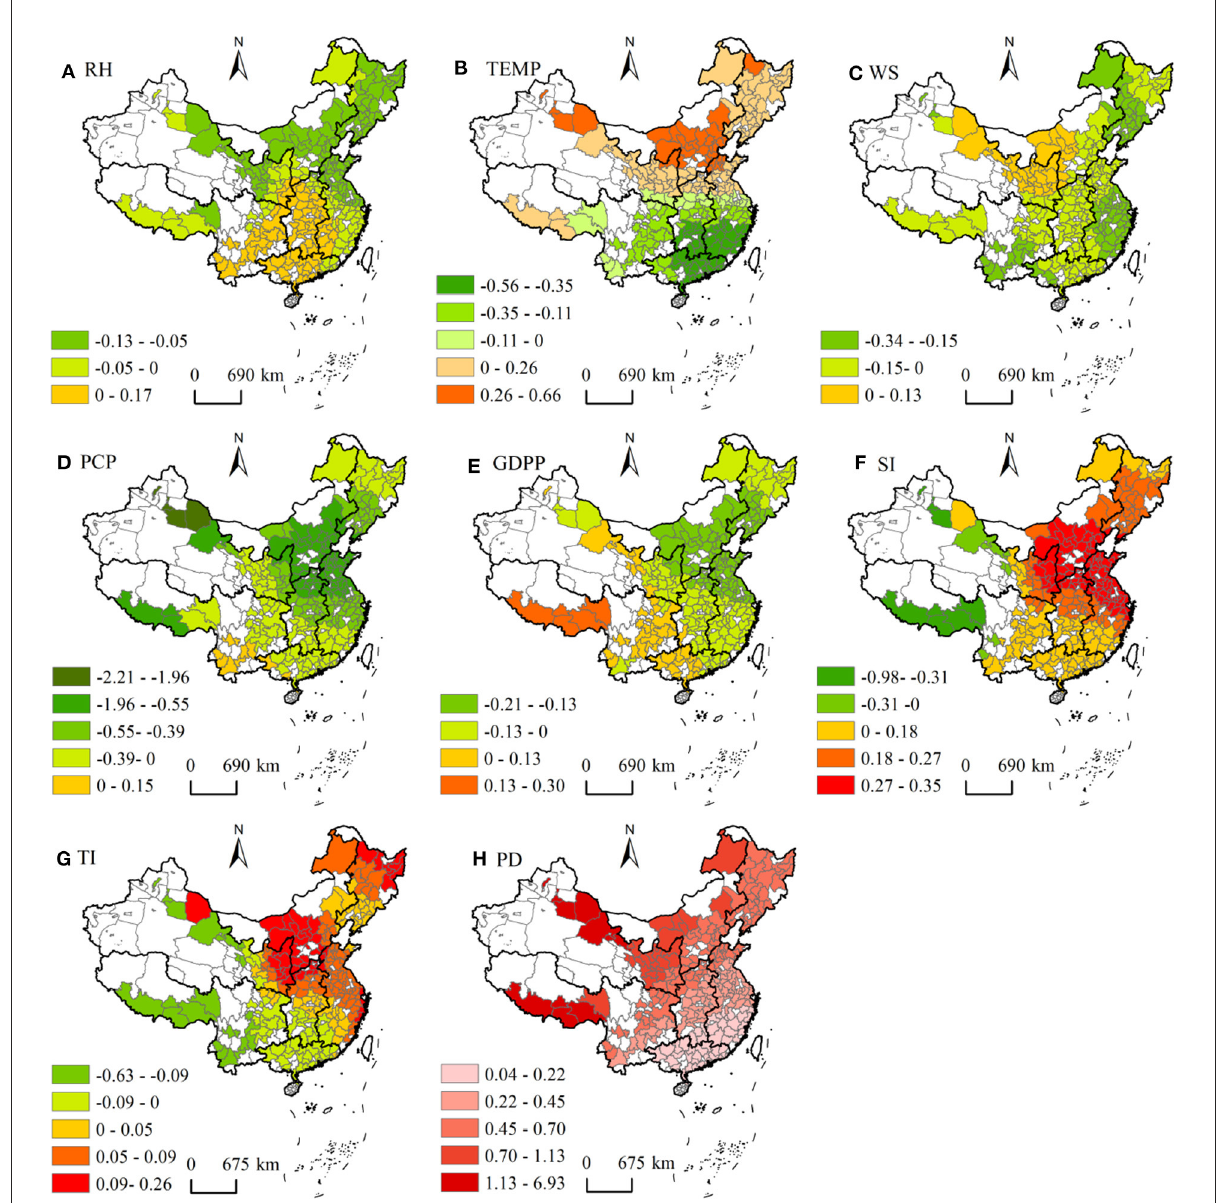
FIGURE5 Spatial distribution of coefficients for each driving factor (A) Relative humidity, (B) Temperature, (C) Wind speed, (D) Precipitation, (E) per capita GDP, (F) Secondary industry share, (G) Tertiary Industry share, and (H) Population density; The white area represents no